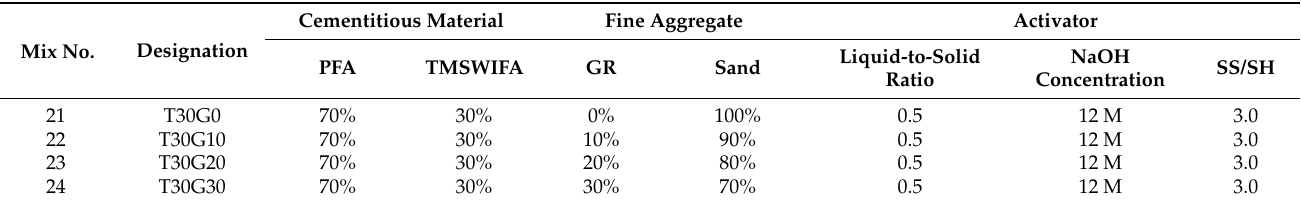
Table 5. Mortar mix ratio